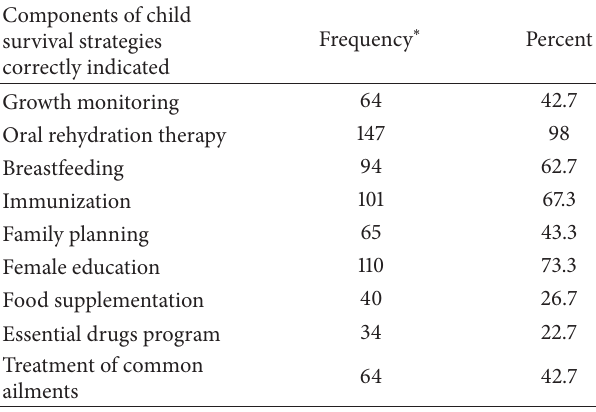
Table 2: Knowledge of child survival strategies.